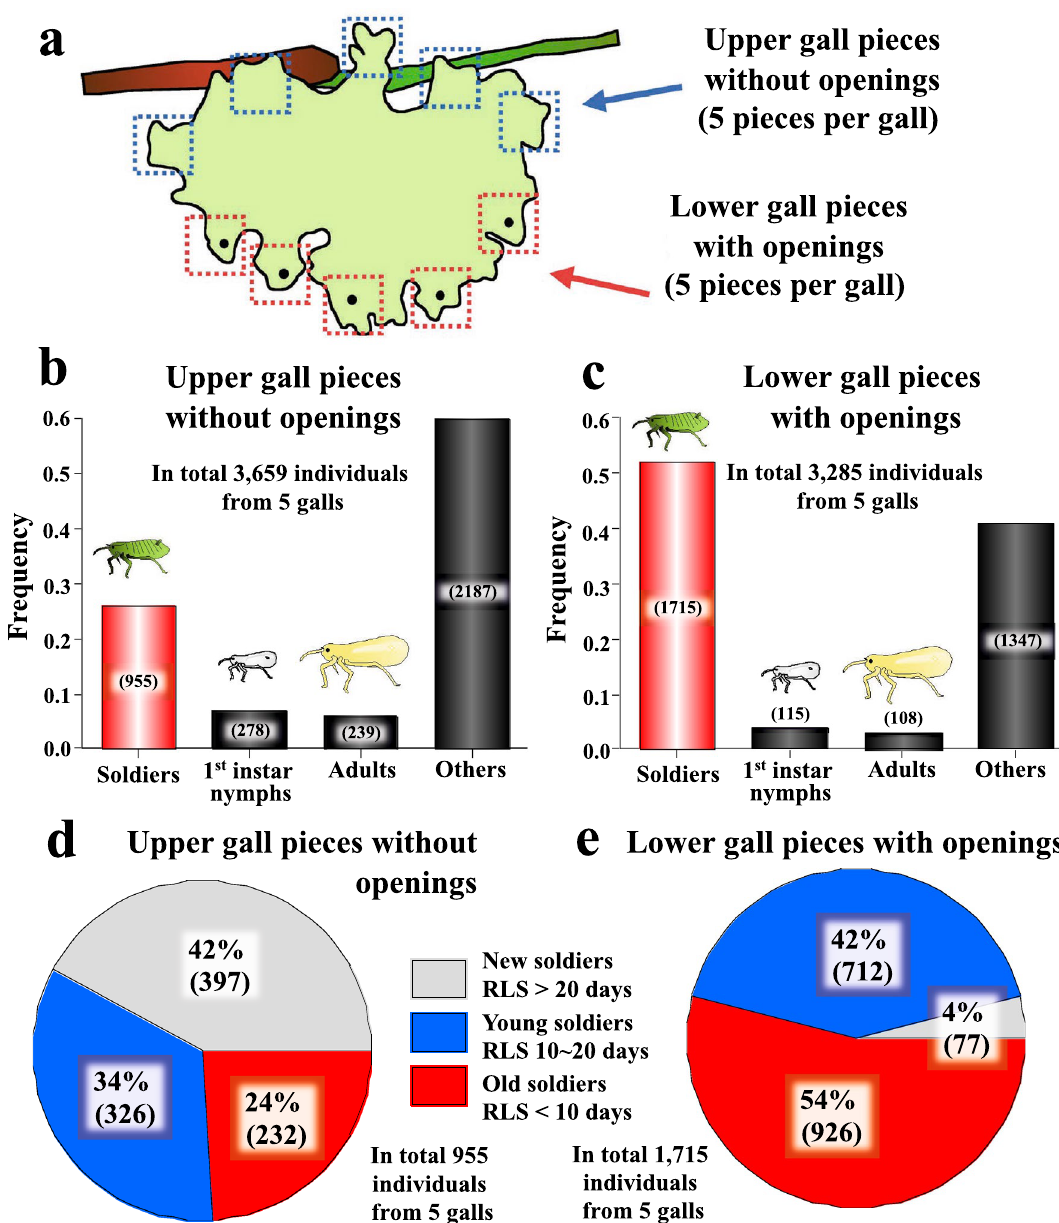
Figure 5. ( a ) Sampling procedures for gall inhabitants of T. styraci from upper gall pieces and lower gall pieces. ( b , c ) Compositions of gall inhabitants in upper gall pieces ( b ) and lower gall pieces ( c ). The insects were categorized into soldiers, first instar nymphs, adults, and others based on their morphological traits. A statistically significant difference was found in frequencies of four aphid classes between upper gall pieces and lower gall pieces (Chi-square test; P < 0.0001). ( d , e ) Age compositions of soldiers collected from upper gall pieces ( d ) and lower gall pieces ( e ). The remaining life span (RLS) of soldiers was individually evaluated on artificial diet plates, by which they were categorized into the following age classes: new soldiers, RLS > 20 days; young soldiers, RLS 10–20 days; old soldiers, RLS < 10 days. A statistically significant difference was found in frequencies of three age classes between upper gall pieces and lower gall pieces (Chi-square test; P <